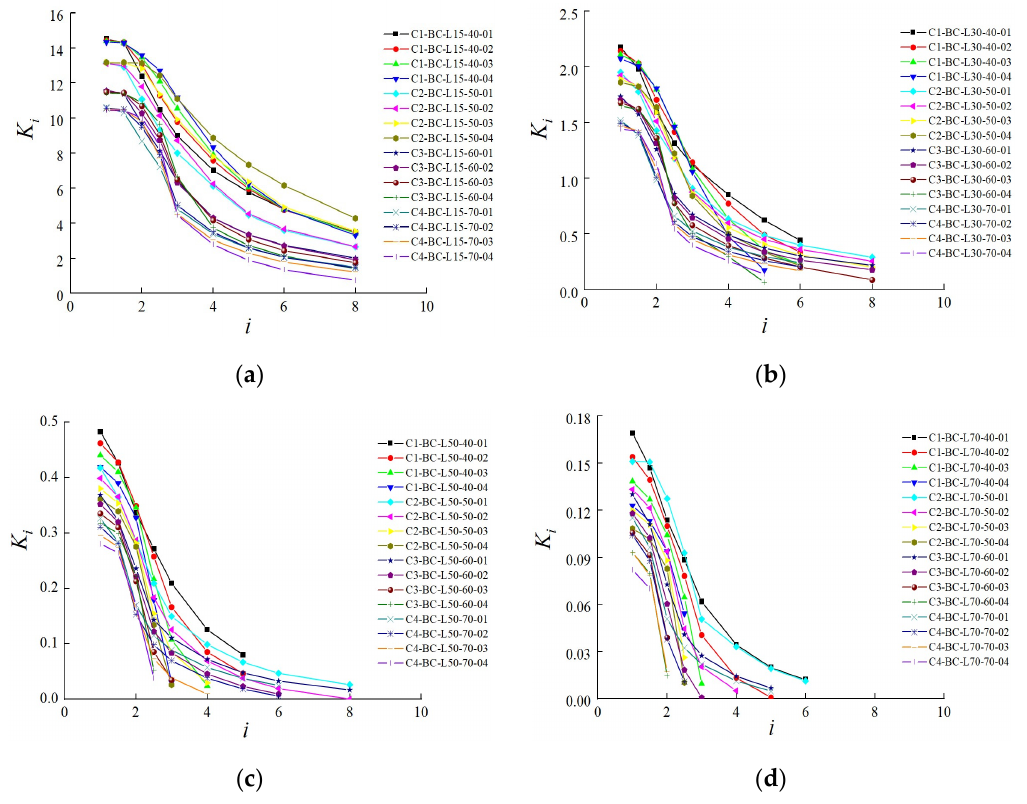
Figure 14. Relationship between K i and i th. ( a ) λ = 15; ( b ) λ = 30; ( c ) λ = 50; ( d ) λ = 70.